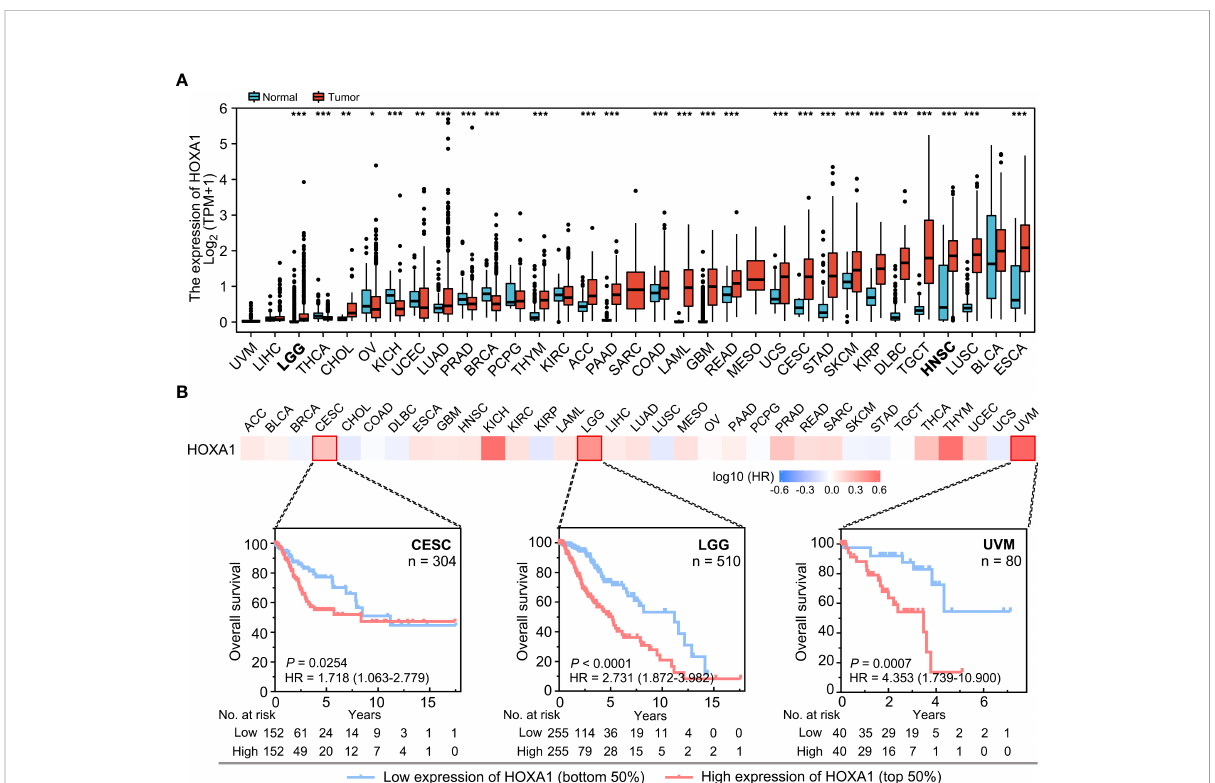
FIGURE 1 HOXA1 expression and the prognostic signi fi cance of HOXA1 in different cancer types. (A) HOXA1 expression in different cancer types. Data are from TCGA. (B) Heatmap of hazard ratios for overall survival according to HOXA1 expression in different cancers. Kaplan – Meier survival curves for CESC, LGG, and UVM are shown. * P < 0.05; ** P < 0.01; *** P <